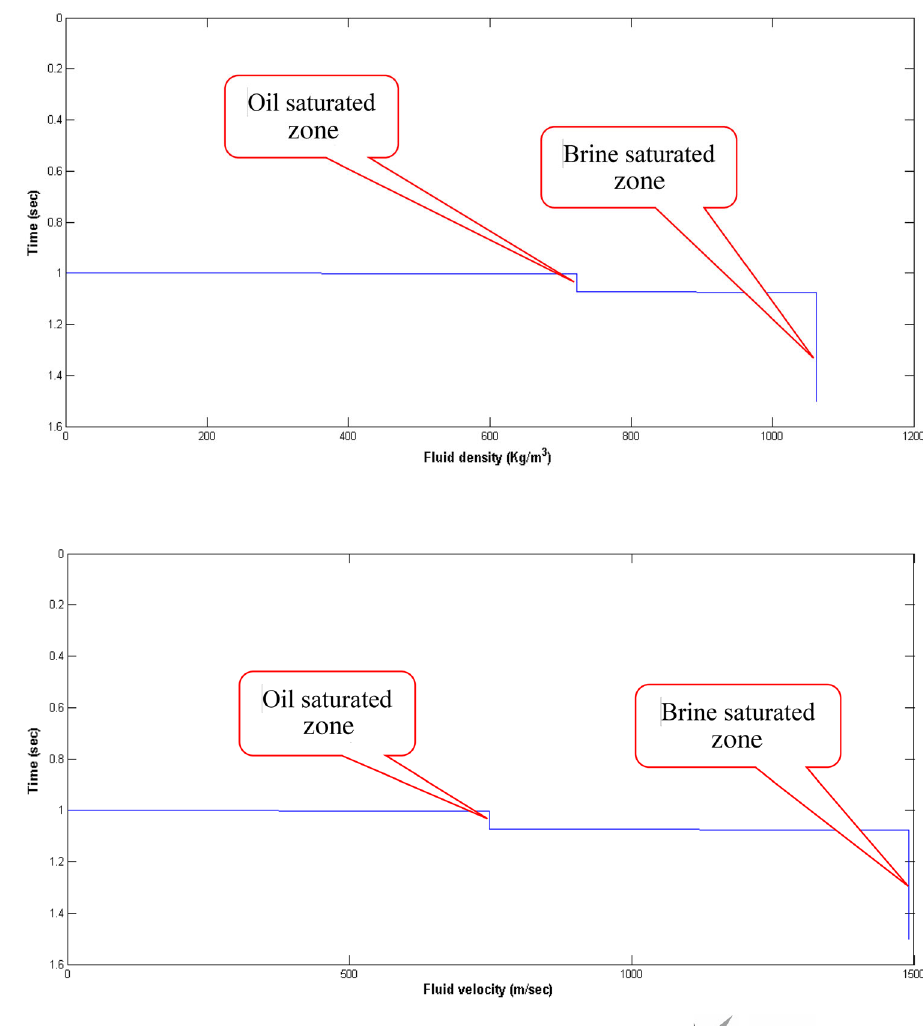
Fig. 15 Fluid density plot with 30% porosity of Arab formation